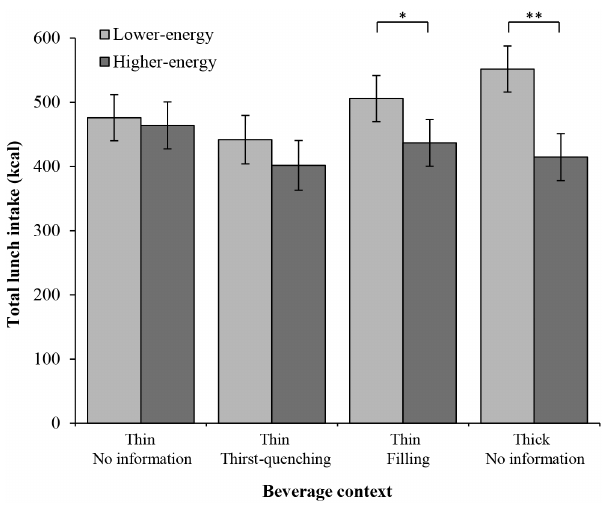
Figure 3. Mean lunch intake ( 6 SEM) after consuming both the lower-energy and higher-energy versions of the drinks across each group, *indicates a significant difference where p . 0.05 and ** p . 0.001.